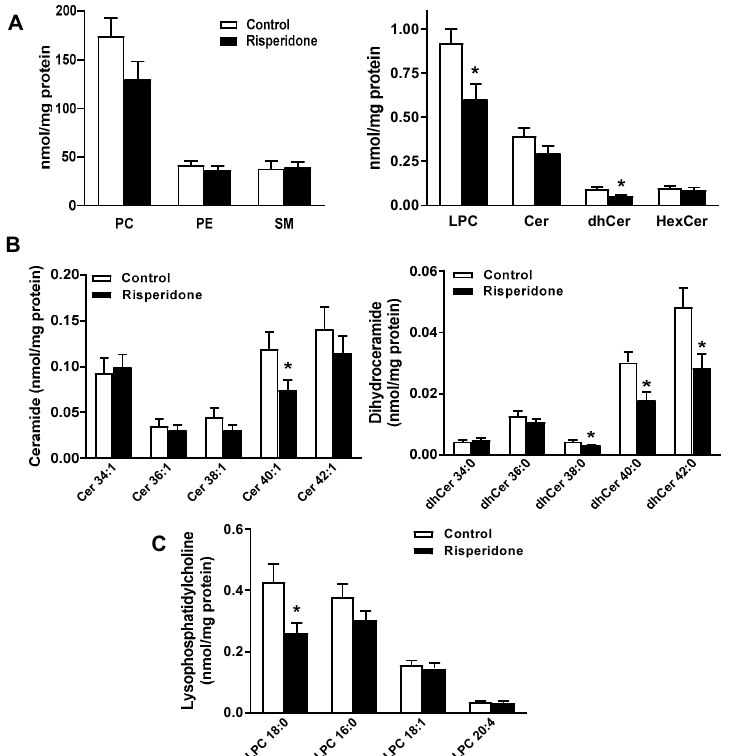
Figure 1. Phospholipid and sphingolipid contents in PBMCs of risperidone-treated older patients and untreated controls. ( A ) Lipid class levels (nmol/mg of protein) of phosphatidylcholine (PC), phosphatidylethanolamine (PE), lysophosphatidylcholine (LPC), sphingomyelin (SM), hexosylceramide (HexCer), ceramide (Cer), and dihydroceramide (dhCer) were measured by mass spectrometry. ( B ) Ceramide and dihydroceramide species. ( C ) Lysophosphatidylcholine species. Results are means ± SEMs of ten samples per group. Statistical comparisons shown are risperidone vs. control (* p < 0.05).